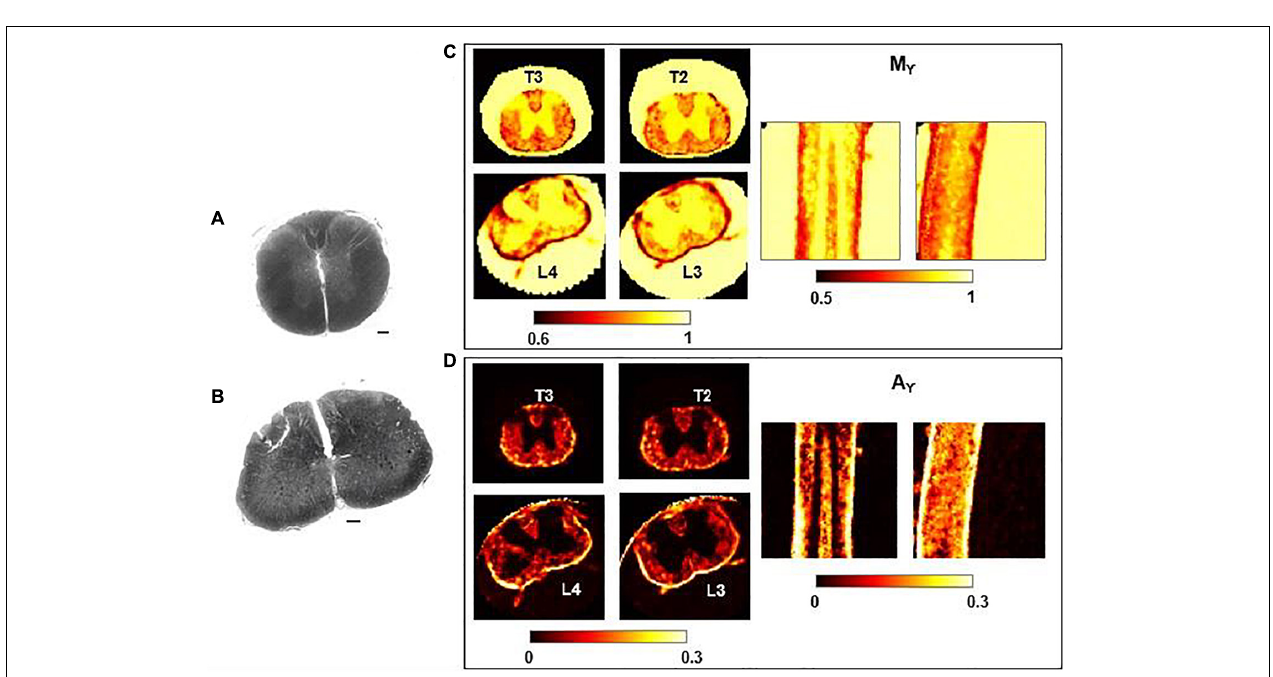
FIGURE 6 | Histology and γ -imaging parametric maps. Optical images of the thoracic segment at the level T2/T3 (A) and of the lumbar segment at level L3/L4 (B) . Scalebar is 100 µ m. (C,D) Parametric maps of mean- γ (M γ ) and γ -anisotropy (A γ ) for the corresponding thoracic and lumbar segments. Axial, coronal and sagittal views are shown, from left to